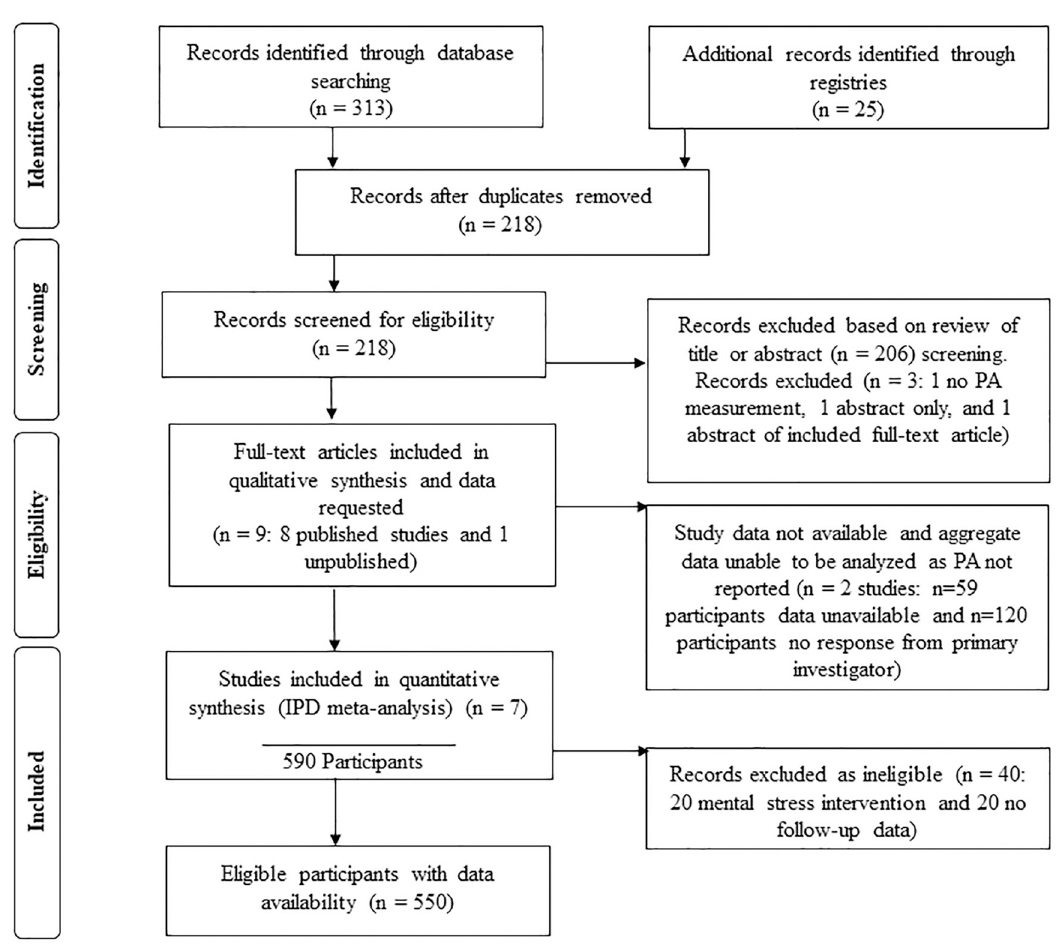
Fig 1. PRISMA flowchart of study and participant